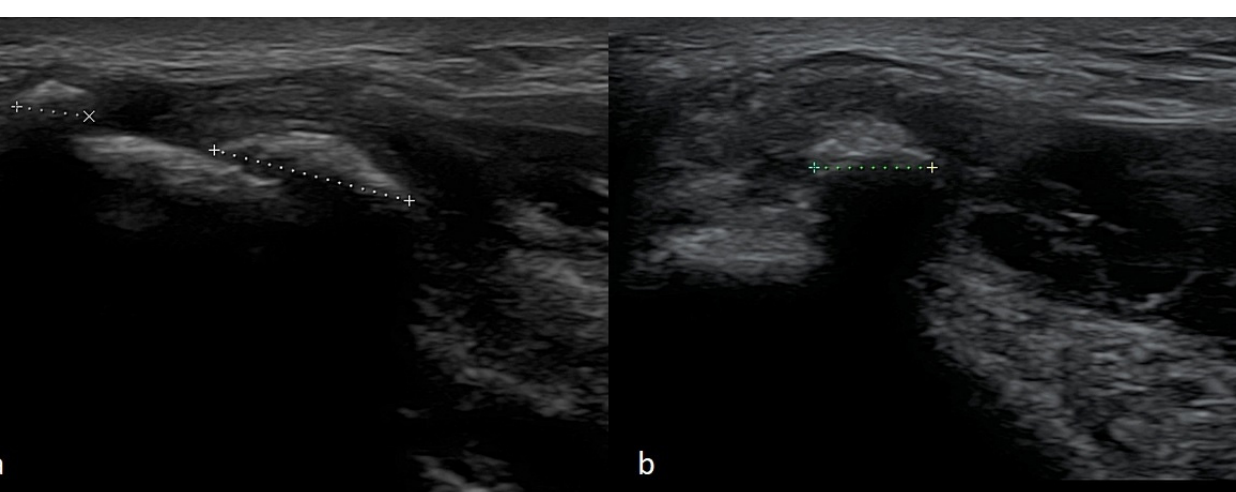
Figure 8. Two cases of post-traumatic changes within the medial collateral ligament and profound part of the common flexor tendon. In both pictures ( a , b ), the areas of hypoechoic scarring are marked with arrowheads; post-traumatic calcifications are also visible. 4. Discussion ME diagnosis may be based on the physical examination and the patient’s medical history. Nonetheless, ME is a relatively uncommon disease with unspecific symptoms, so the entity can easily be confused with other sources of elbow pain—features differentiat- ing ME from other conditions [34,51]. 4.1. Cubital Tunnel Syndrome and Ulnar Neuritis Cubital tunnel syndrome is the second most common compression neuropathy. The ulnar nerve courses behind the medial epicondyle, so the pressure or stretching in this area may affect the shape of the cubital tunnel, which causes pain [34]. However, contrary to ME, where pain with activity is the leading symptom, most patients report sensory loss first. Numbness, tingling sensation, and weakness of the forearm muscles can also occur [34,52]. Diagnosis of cubital tunnel syndrome may be facilitated with the Tinel test, which involves direct gentle compression over the nerve course at the elbow level. The test is